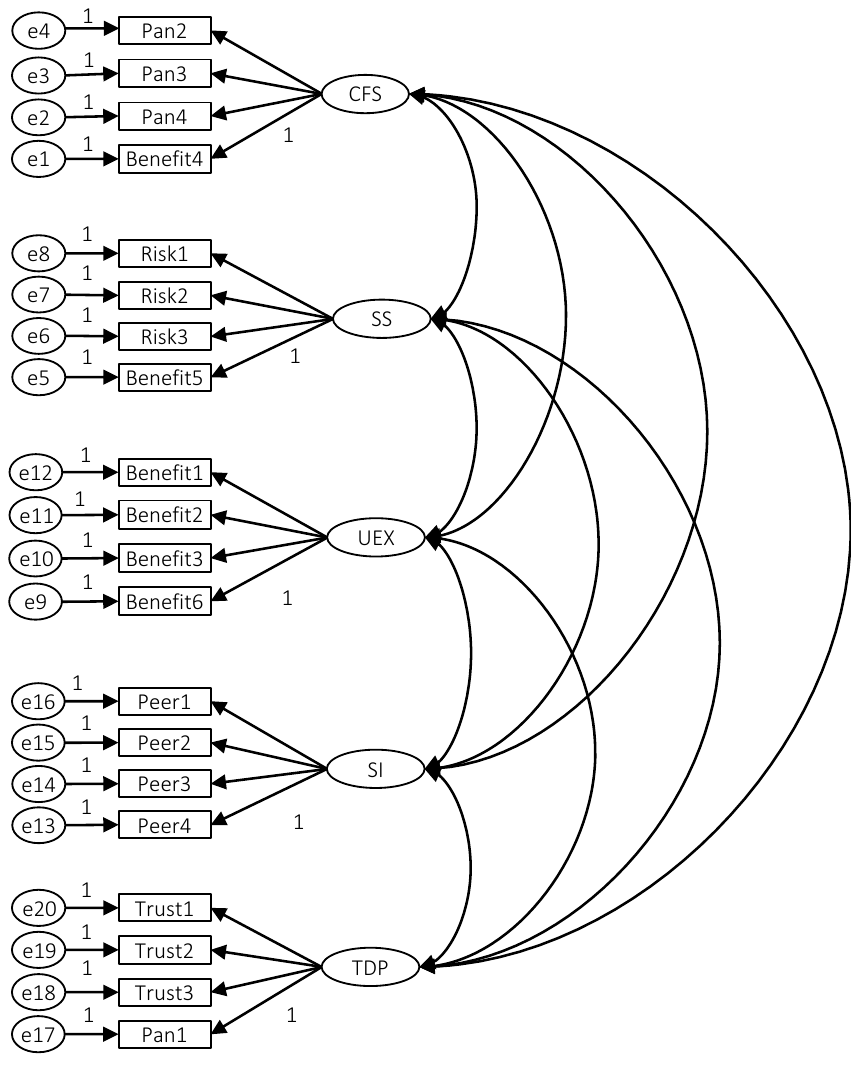
Figure 2. Confirmatory factor